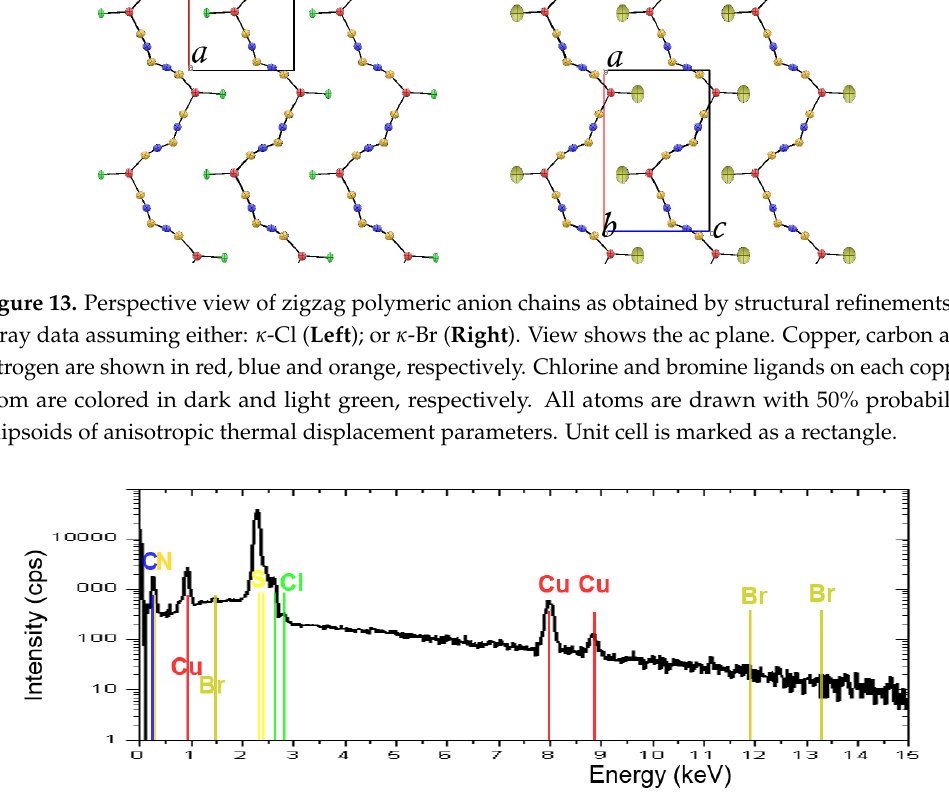
Figure 14. Energy Dispersive X-ray Spectra (EDXS) recorded at 300K. Only characteristic lines for C, N, S and Cu, and in particular for ClK α at 2.59keV and for ClK β at 2.83keV were observed with intensities that correspond to the chemical formula of κ -Cl. On the other hand, no significant intensity for lines BrK α 1 and BrK α 2 at 11.92keV, for BrK β at 13.29keV, and for BrL α at 1.49keV were observed, which would be expected in the presence of